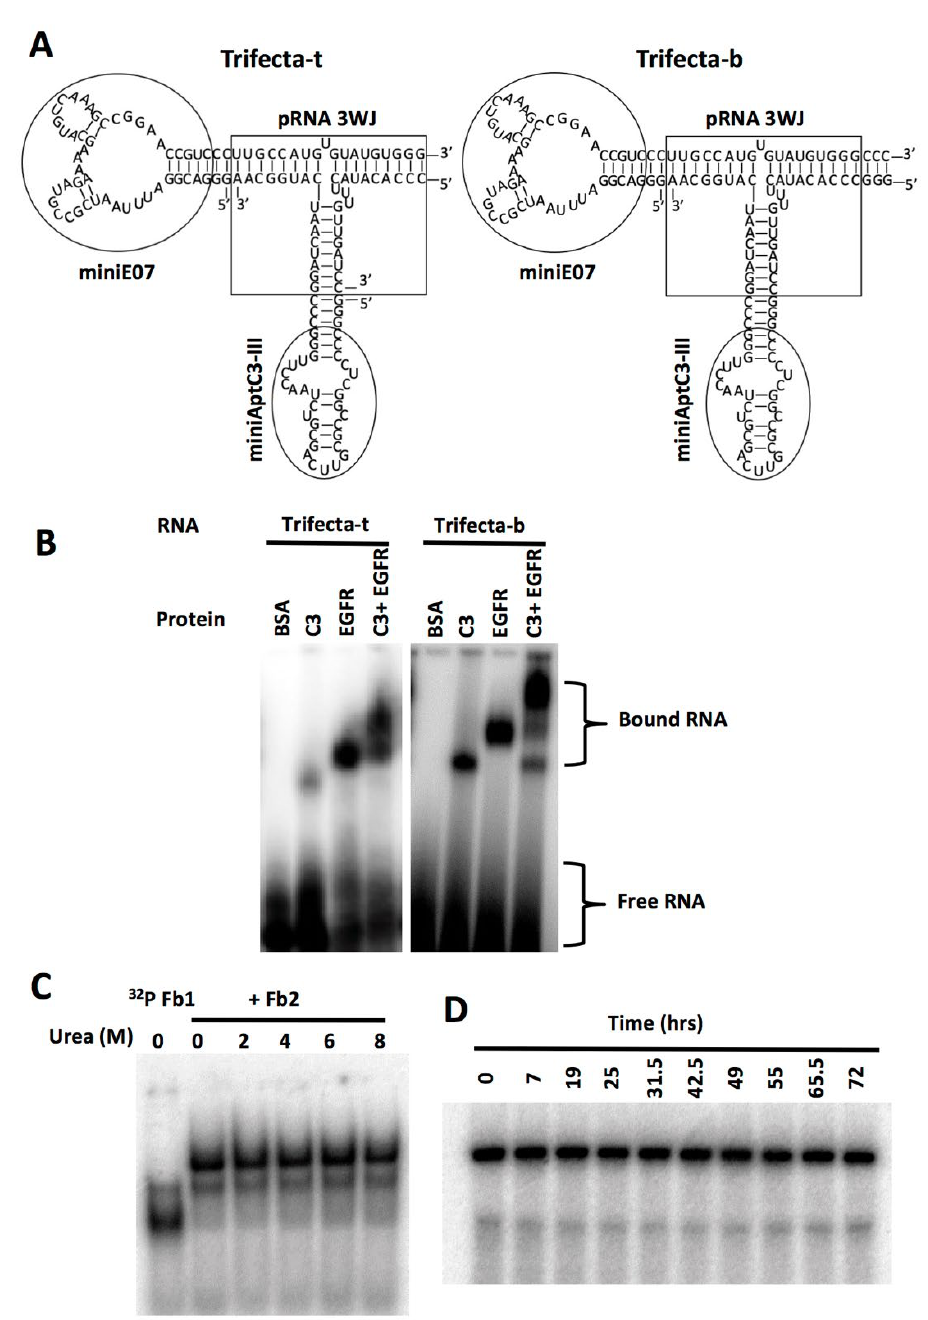
Figure 4. Triple complex formation and stability of a bi-valent aptameric adaptor. ( A ) Secondary structure of the “Trifecta” constructs. A tri-molecular construct (Trifecta-t) is shown on the left and a bi-molecular construct (Trifecta-b) on the right. ( B ) Triple complex formation with EGFR-Fc and iC3b. EMSA showing single and double occupancy of the bivalent constructs, trimolecular version (Trifecta-t) on the left and bi-molecular version (Trifecta-b) on the right. EGFR = EGFR-Fc. On both gels the strand containing the C3 aptamer was labeled with α 32 P-ATP. ( C ) Stability against strand dissociation. The fragment Fb1 was labeled with α 32 P-ATP by in vitro transcription and assembled with unlabeled Fb2. After incubation with urea, the sample was run on 8% native acrylamide gel in ½x TBE buffer and visualized by phosphorimager. ( D ) Stability against degradation. Stability of Trifecta-b is shown in the presence of 50% human serum incubated at 37 °C for the time indicated. The sample was run on 8% urea gel and visualized by phosphorimager.